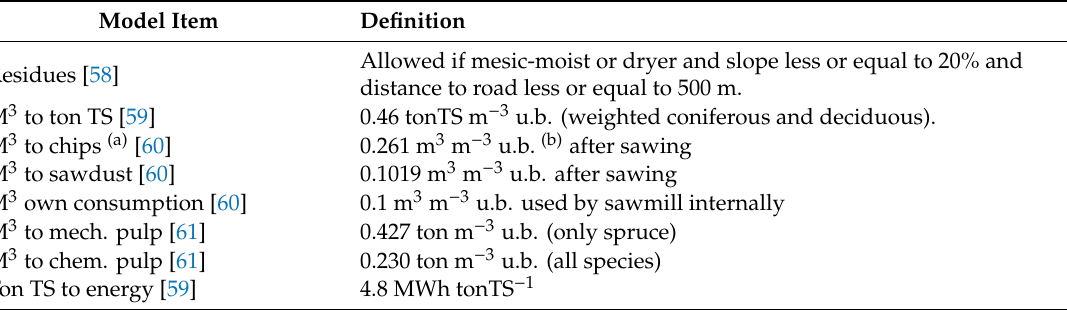
Table A27. Supply side model parameters including Leontief production function coe ffi